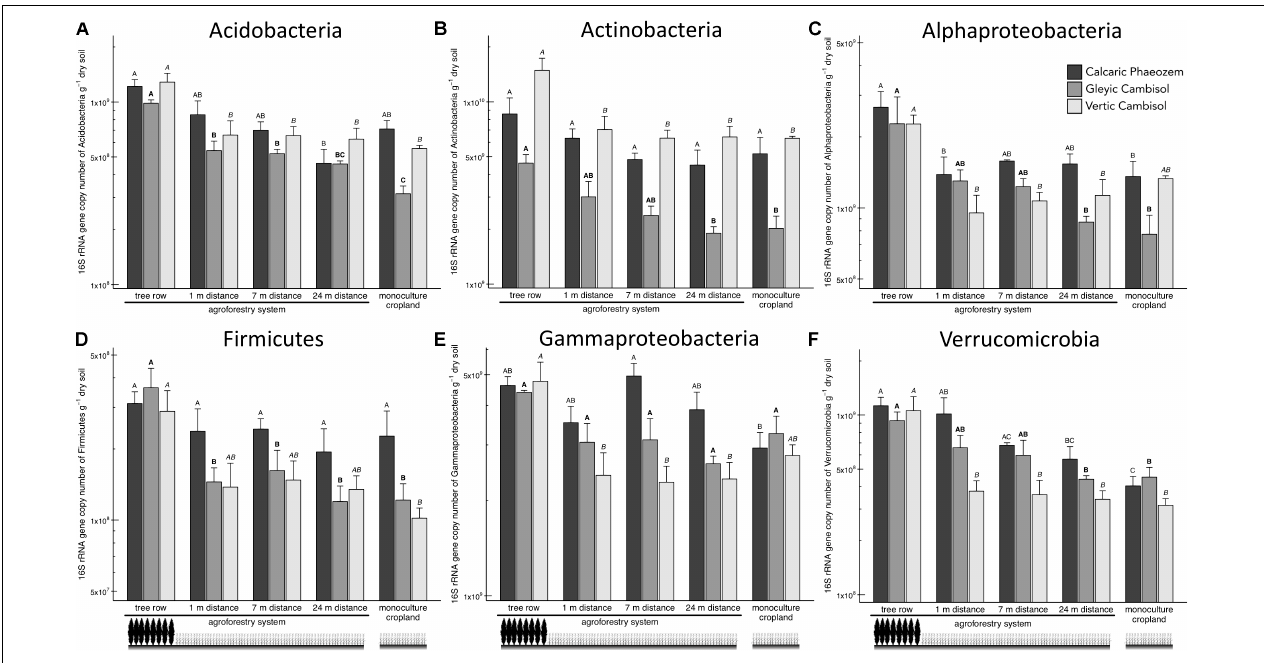
FIGURE 3 | 16S rRNA gene abundance of six bacterial groups [ (A) Acidobacteria, (B) Actinobacteria, (C) Alphaproteobacteria, (D) Firmicutes, (E) Gammaproteobacteria, and (F) Verrucomicrobia] in soils of three paired temperate agroforestry and monoculture cropland systems. Means (bars are standard errors; n = 4) with different uppercase letters of the same font indicate significant differences among the sampling locations (the tree row, 1, 7, and 24 m within the crop row of the agroforestry and the monoculture croplands) within one soil type (one-way ANOVA with Tukey’s HSD test of log 10 -transformed data at p < 0.05).